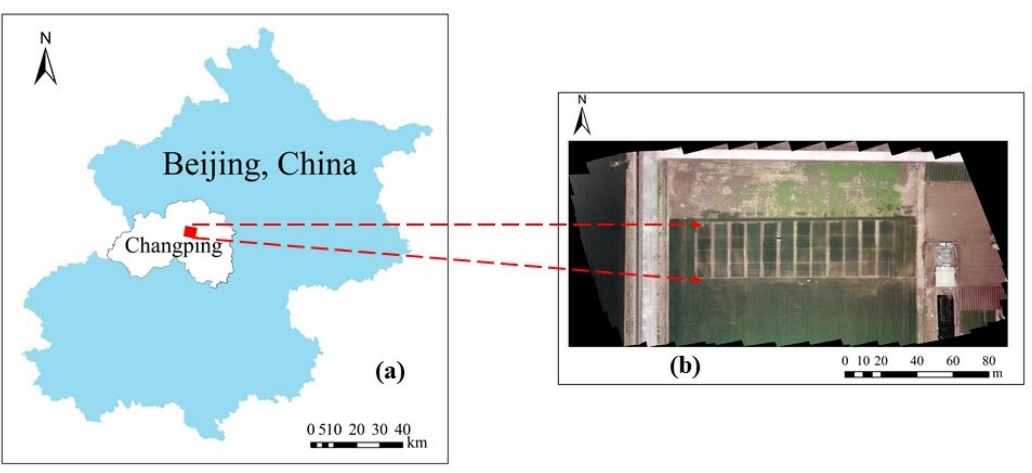
Figure 1. Location of the test area. ( a ) location of Changping District in Beijing; ( b ) image of test area acquired by unmanned aerial vehicle (UAV).